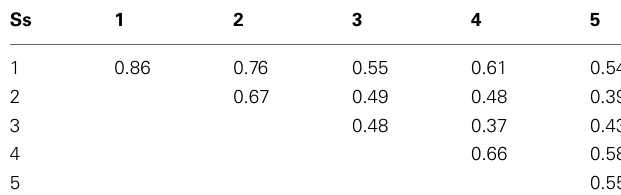
Table 2 | Pearson correlation coefficients between individual subjects’ dissimilarity matrices and (on the diagonal) between individuals’ ij and ji half-matrices.